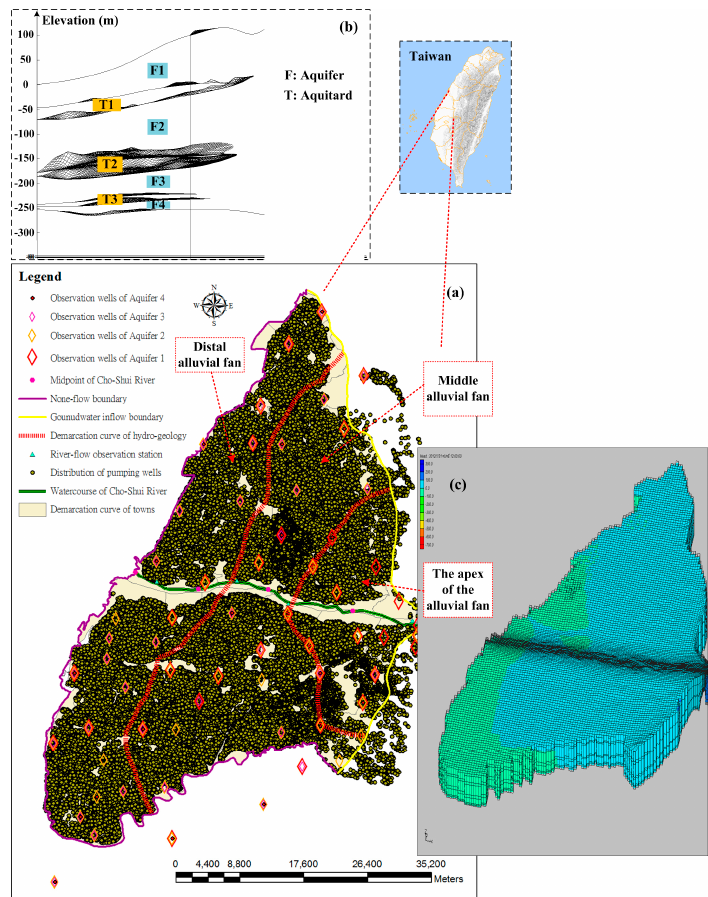
Figure 6. Study area: ( a ) distribution of groundwater monitoring wells, pumping wells, and sub-alluvial fan; ( b ) aquifer/aquitard stratification profile across all drilling wells; ( c ) constructed hydrogeological gridding structure of groundwater modeling.